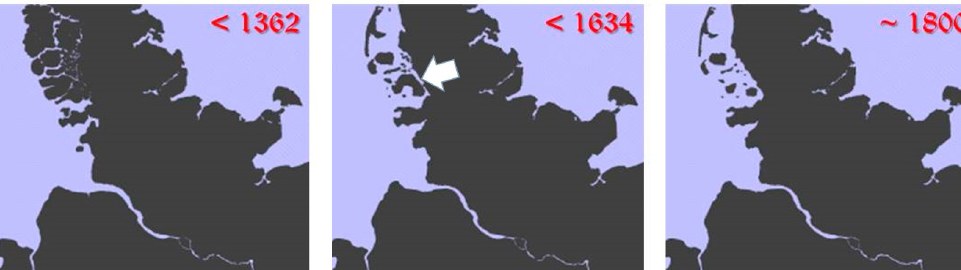
Figure 1. Changes in the German North Sea coastline during the past 700 years (note the upper left part of each panel), after [1]. The left panel shows vast coastal wetlands that were lost after the first “ Grote Mandrenke ” in 1362. In the middle panel, the horseshoe-shaped island of Strand (white arrow) can be seen, whose major, central parts got lost after the second “ Grote Mandrenke ” in 1634.